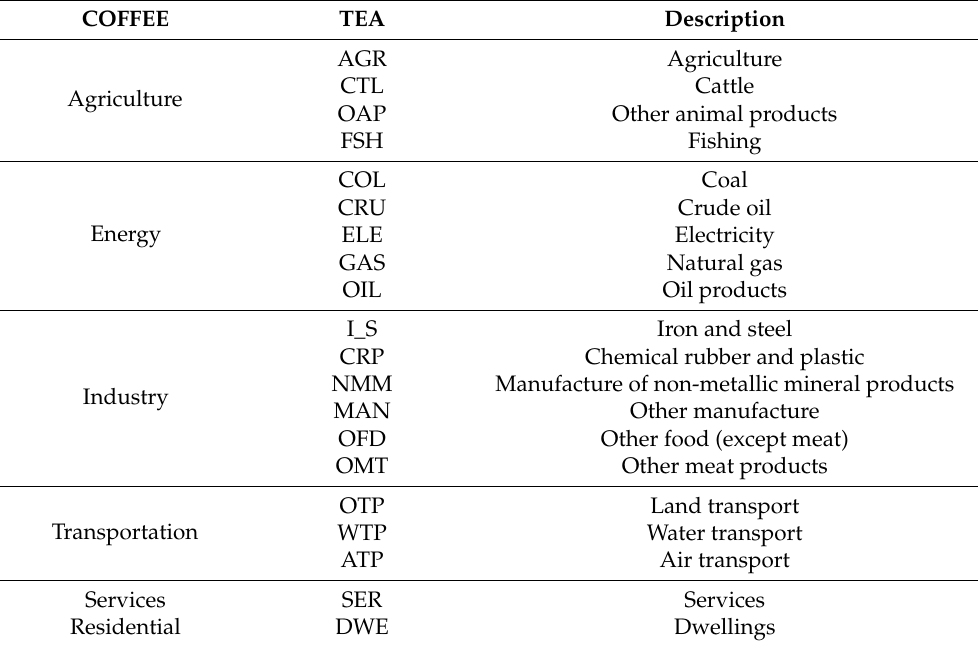
Table A1. Sectoral coverage in COFFEE-TEA IAM